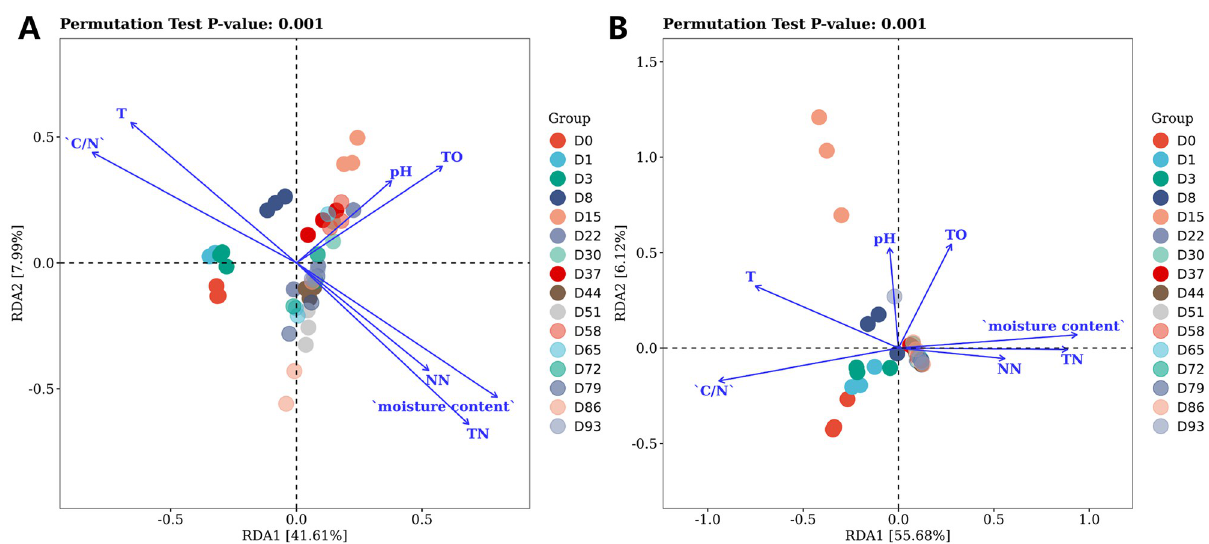
Fig 9. Redundancy analysis (RDA) of bacterial communities and environmental factors. RDA used to assess the relationships of bacterial communities (A) and environmental factors, as well as fungal communities (B) and environmental factors during the EFS process. The values of axes are the percentages explained by the corresponding